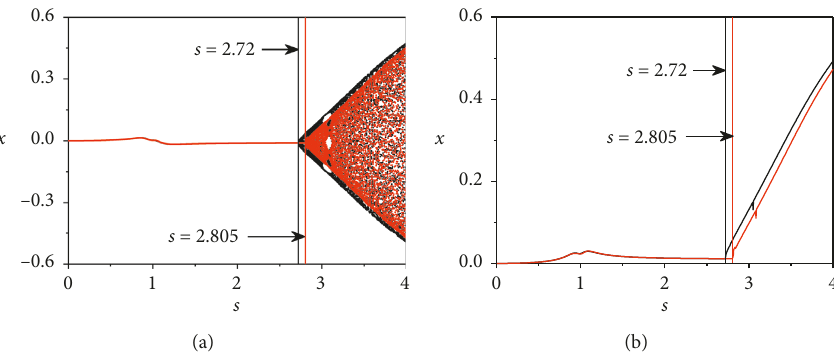
Figure 10: The comparison results of (a) the bifurcation diagram and (b) the amplitude-frequency response